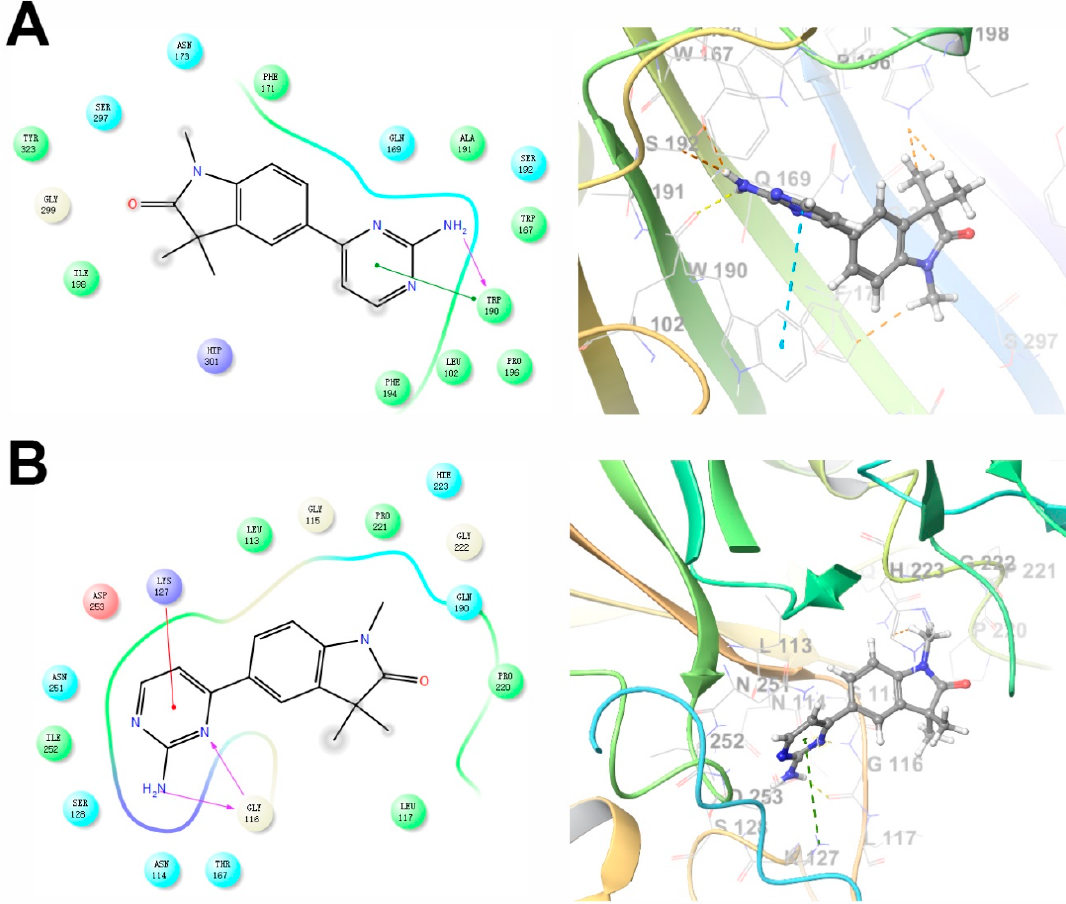
Figure 3. Cont Figure 3. Cont.